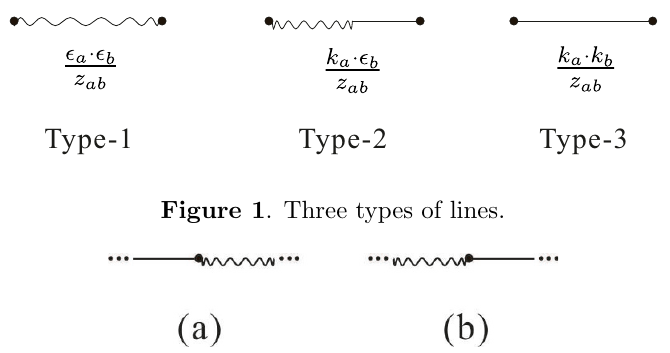
Figure 1 . Three types of